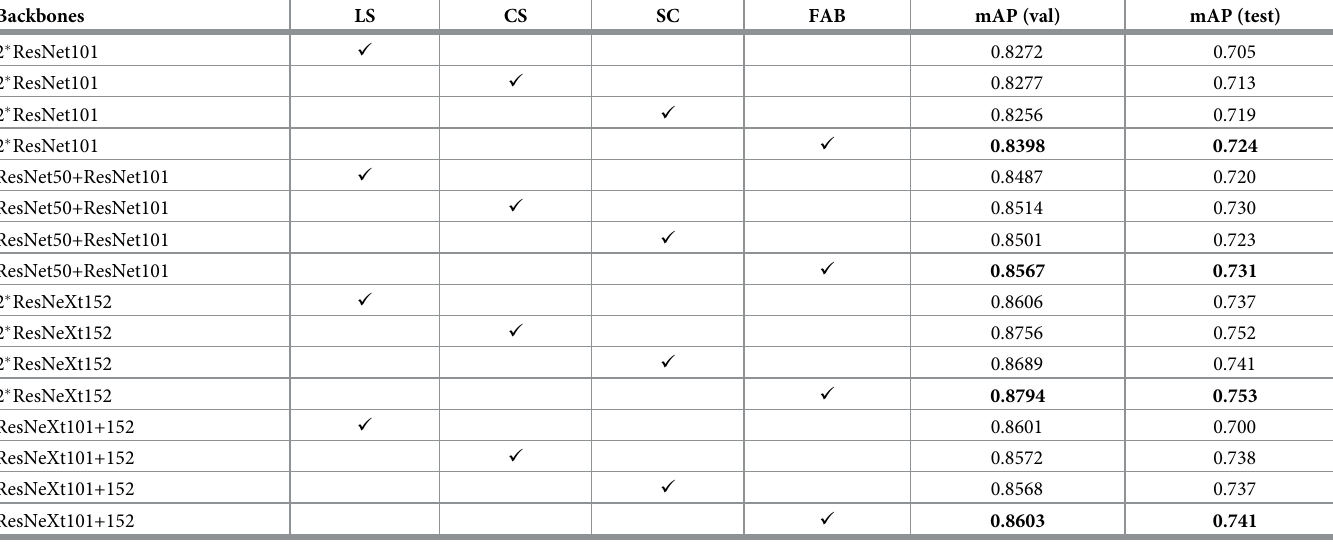
Table 4. Effectiveness of feature augmentation operations. LS, CS, SC are short for layer swap, channel swap, spot cover, respectively.